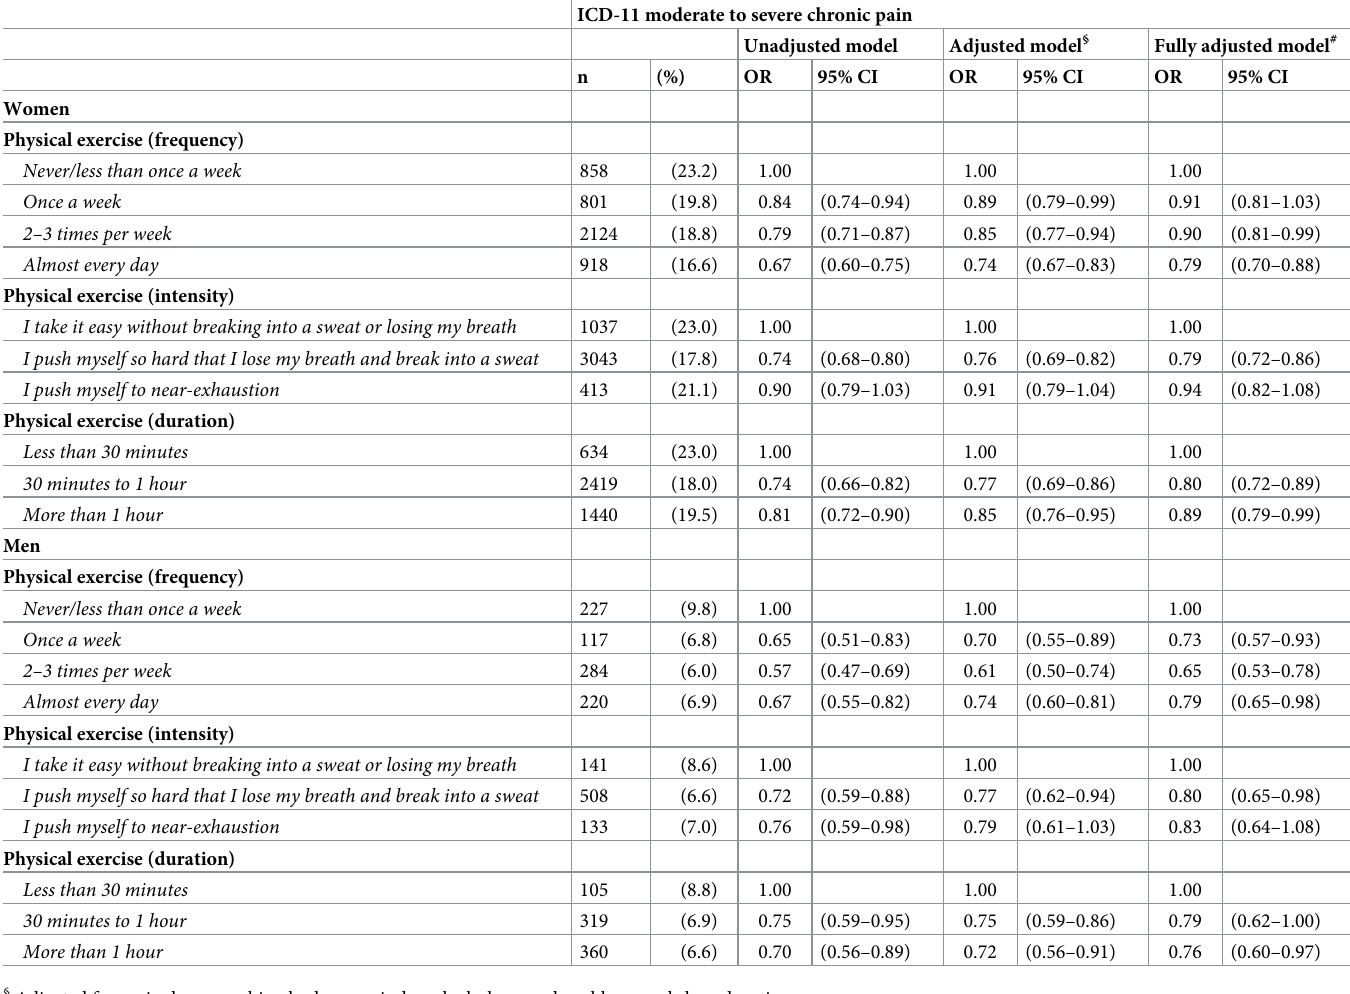
Table 3. Association between physical exercise and moderate to severe chronic pain in male and female university and college and university